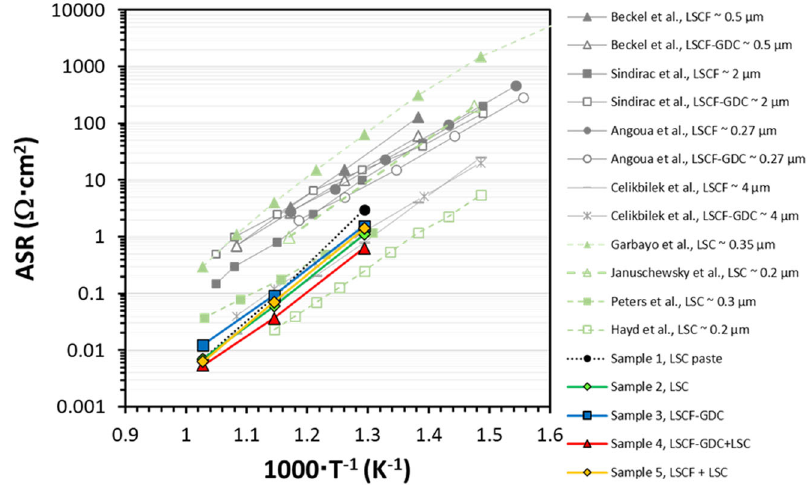
Fig. 4 Arrhenius plot of the area-speci fi c resistance (ASR). ASR of the symmetrical cells having various con fi gurations (refer to Supplementary Table 1) in this study are compared with values for LSC, LSCF, and LSCF-GDC nanocomposite cathodes, presented in literature 16,37 – 39,52 –